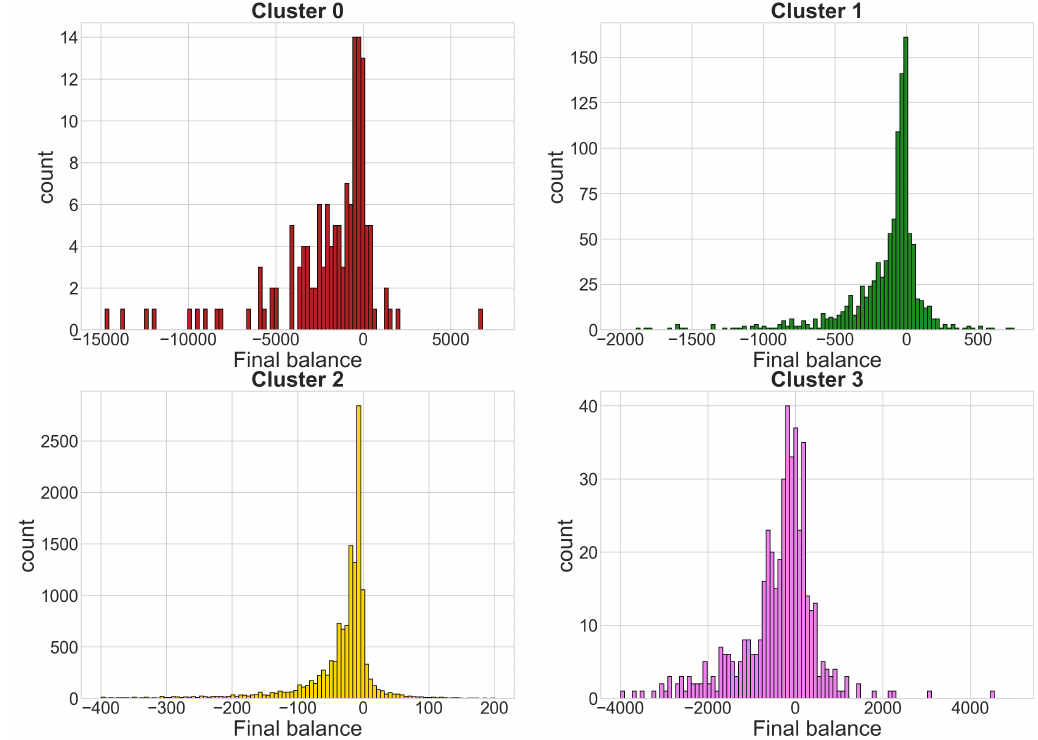
Figure 5. Histograms of the total balance obtained using the time series k -means algorithm. The x axis reports the balance, while the y axis shows the number of players that obtained that balance during the